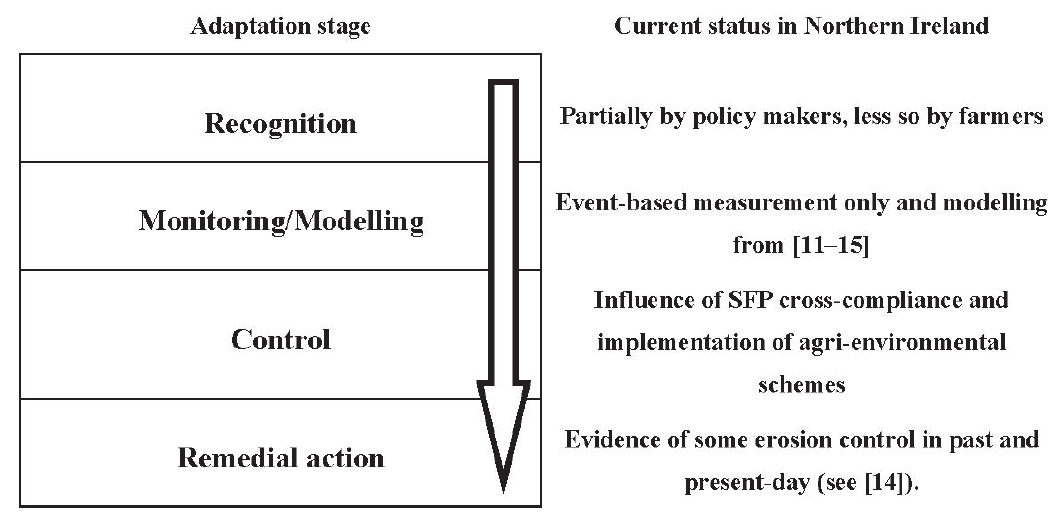
Figure 3. Stages required to achieve necessary adaptation measures for controlling soil erosion now and in the future and their current status in Northern Ireland ( after